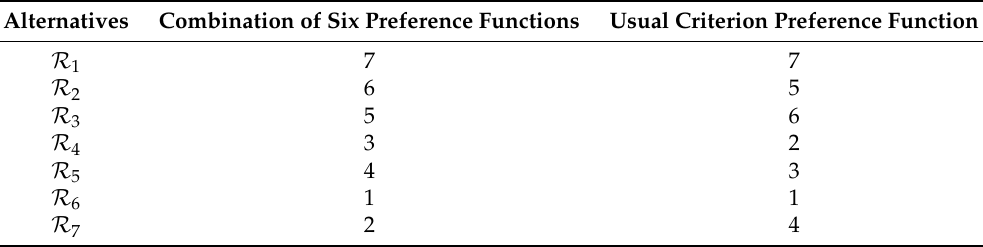
Table 17. Final ranking of hydroelectric power plants.